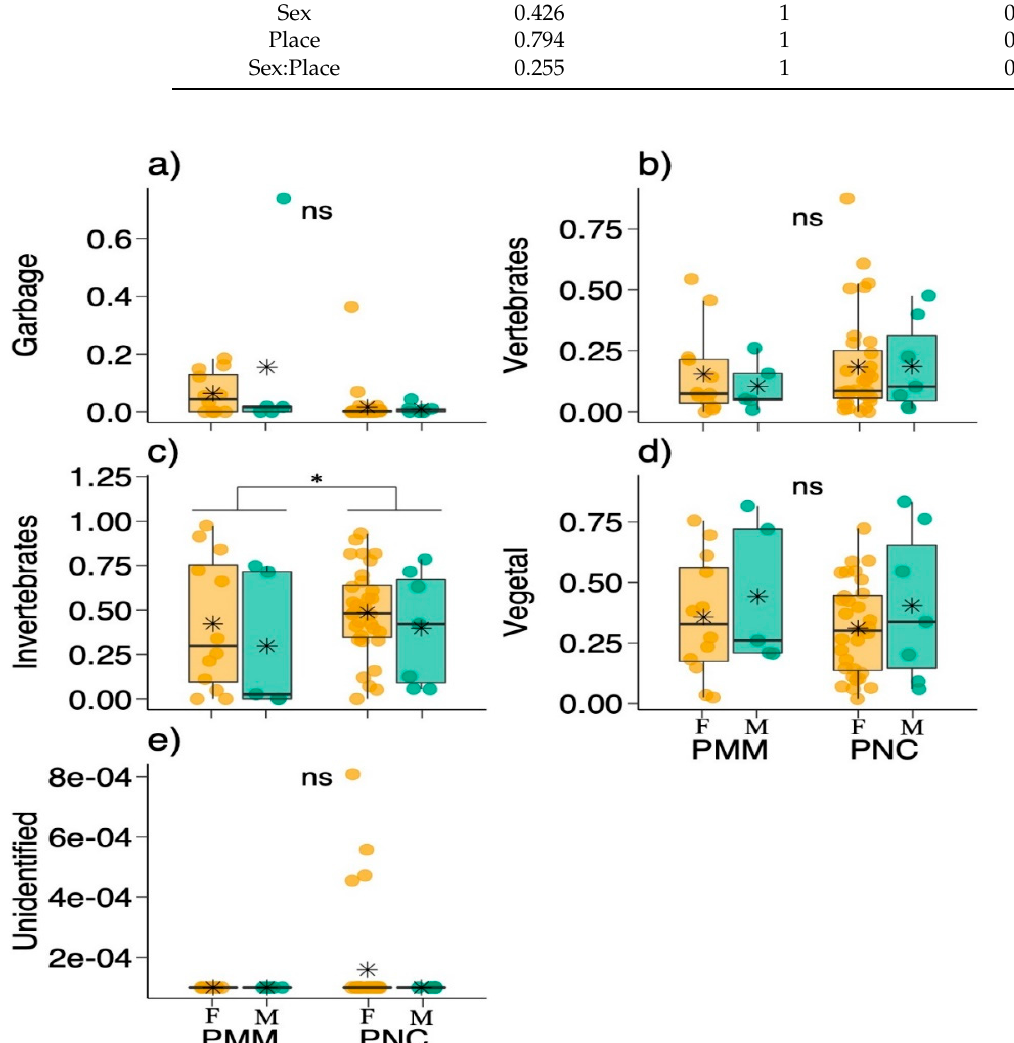
Figure 2. Variation in the percentage occurrence of food categories between female and male coatis ( Nasua nasua ) in two different parks, PMM (Parque Municipal Mangabeiras) and PCN (Parque Nacional do Caparaó). ( a ) Comparison of garbage consumption between males and females from both parks, PMM and PNC. ( b ) Comparison of vertebrate consumption between males and fe-males from both parks, PMM and PNC. ( c ) Comparison of invertebrate consumption between males and females from both parks, PMM and PNC. ( d ) Comparison of vegtal consumption be-tween males and females from both parks, PMM and PNC. ( e ) Comparison of unidentified mate-rial consumption between males and females from both parks, PMM and PNC. ns—non-significant. Asterisk at the top of panel ( c ) represents a significant difference between parks ( p < 0.05). Boxplots are represented by first and third quartiles, median, and mean (*). Statistical results are depicted in Table 2. F—Female, M—Male. Asterisks on the boxplots represent the mean. PMMF, female coati from Parque Municipal Mangabeiras; PMMM, male coati from Parque Municipal Mangabeiras; PNCF, female coati from Parque Nacional do Caparaó; PNCM, male coati from Parque Nacional do Caparaó. Ns, no significant. Table 1. Contrast tables of the contribution of individual food categories (garbage, vertebrates, invertebrates, vegetal, and unidentified) to the overall Bray–Curtis dissimilarity of the composi- tion of food ingested by females and males of coatis ( Nasua nasua ) in two different parks (PMM and PNC). PMMF—PMM and female coati, PMMM—PMM and male coati, PNCF—PNC and female coati, PNCM—PNC and male coati. PMM, Parque Municipal Mangabeiras; PNC, Parque Nacional do Caparaó; PMMF, female coati from Parque Municipal Mangabeiras; PMMM, male coati from Parque Municipal Mangabeiras; PNCF, female coati from Parque Nacional do Caparaó; PNCM, male coati from Parque Nacional do Caparaó. Av.dissim, average dissimilarity; SD, stand- ard deviation. NO, unidentified. Contrib., contribution. PMMF_PMMM Av. Dis- sim SD